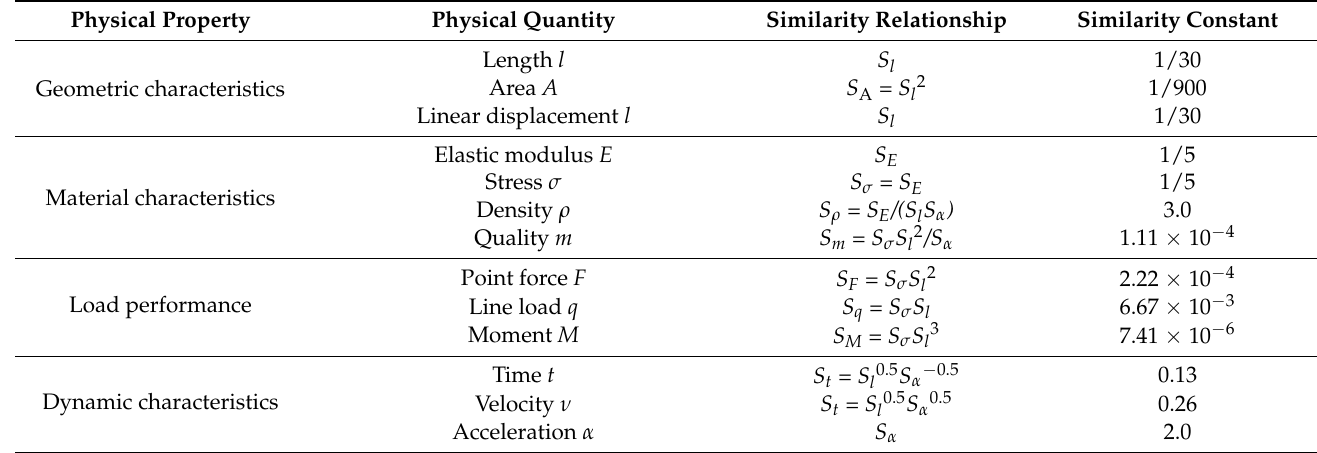
Table A3. Similar constants in the test model.